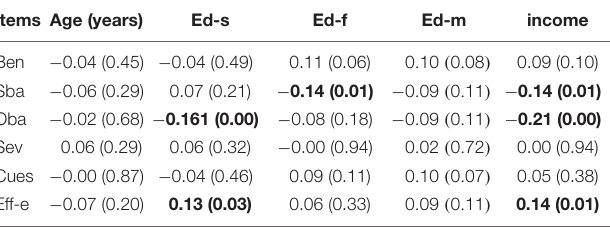
TABLE 3 | The relationship between demographic factors and exercise health beliefs ( n = 313).